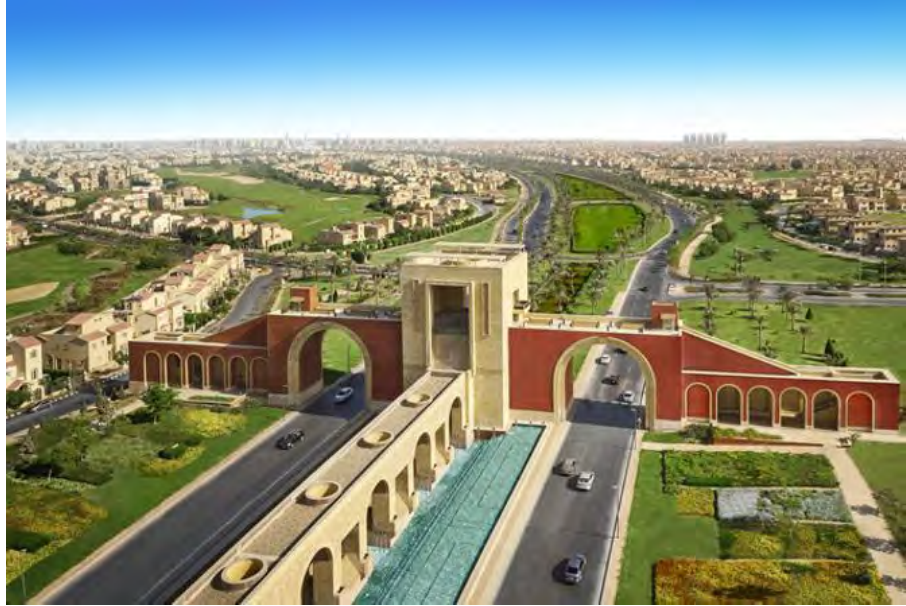
Fig. 3: Madinty entrance fountains. (Madinty.com,2018)